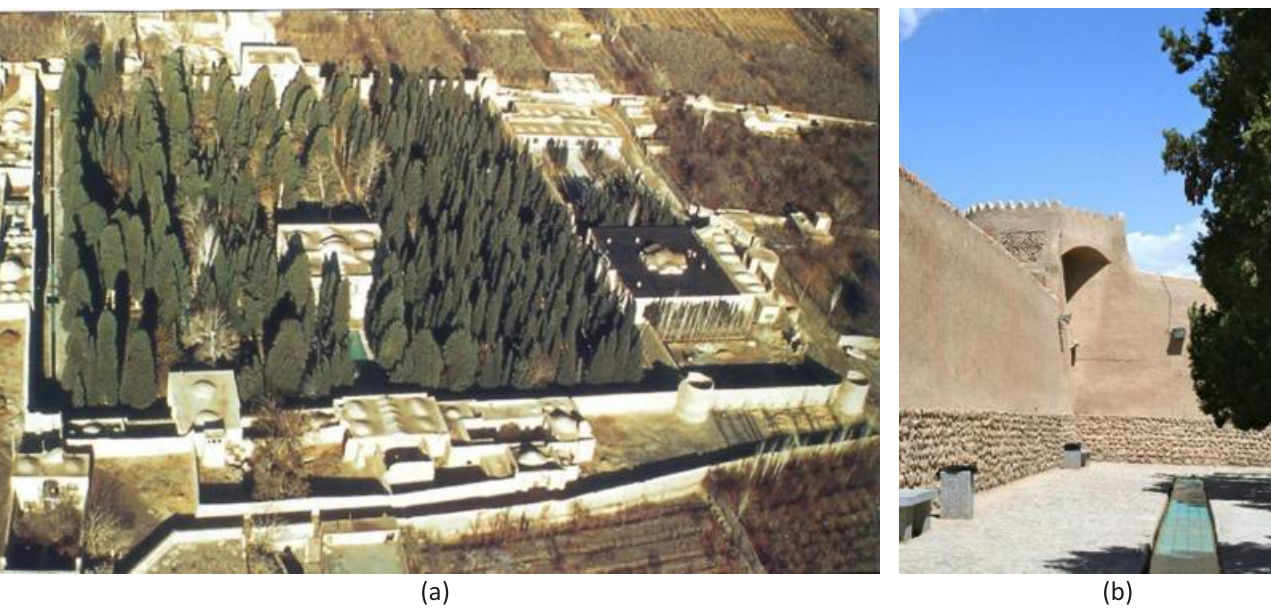
Figure 9. (a) Arial picture of Fin garden enclosed between walls (Khansari et al. 1998); (b)The Fin Garden surrounded by high walls with four towers at the corners and a monumental two level entrance in its south façade. Photo by: Azadeh